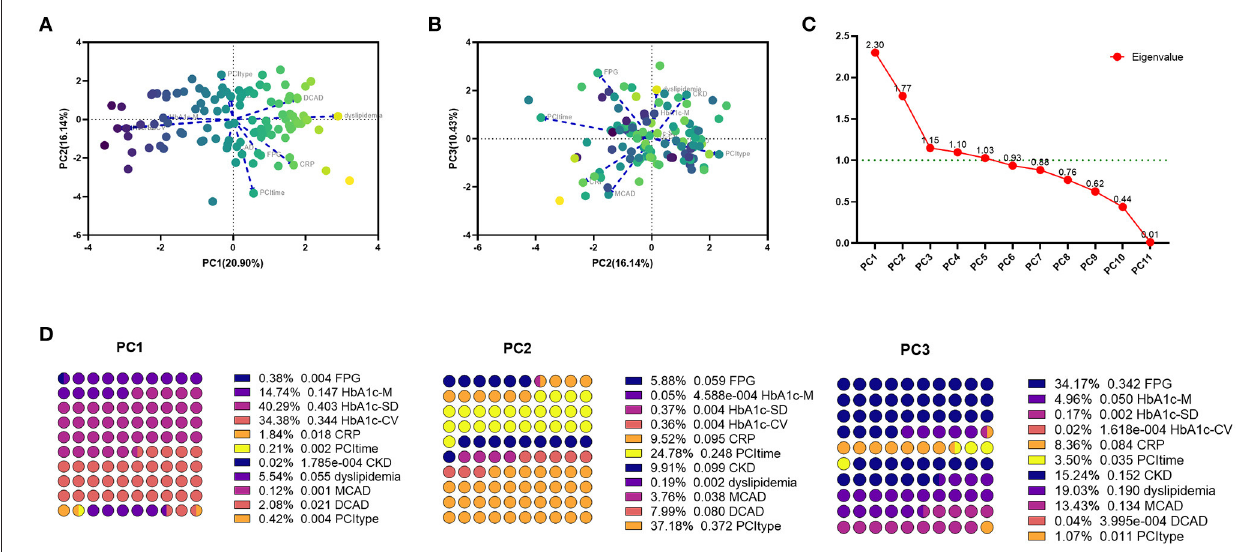
FIGURE 6 | CATPCA analysis of clinical variables in the PSM cohort. (A,B) CATPCA biplot—component loadings of the most explanatory variables. (C) The scree plot of CATPCA. (D) Risk factors in PC1, PC2, and